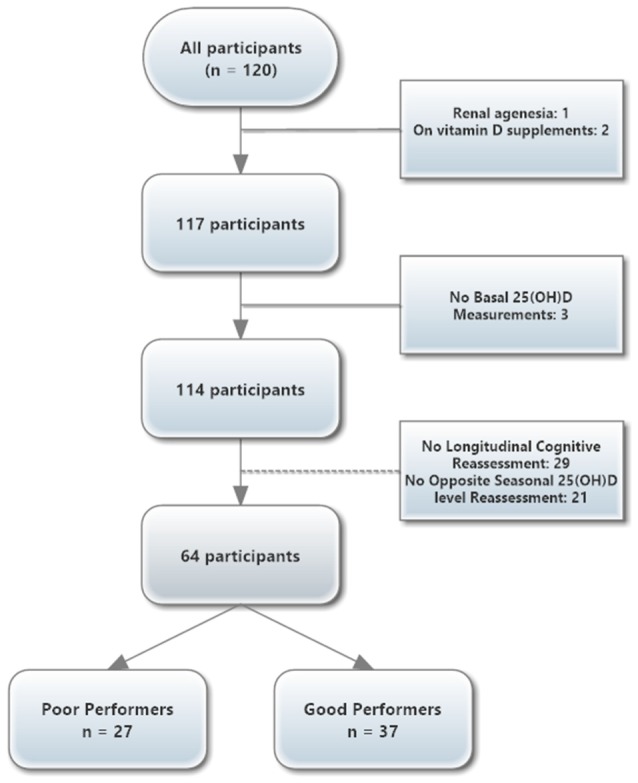
Overview of the participant flowchart.